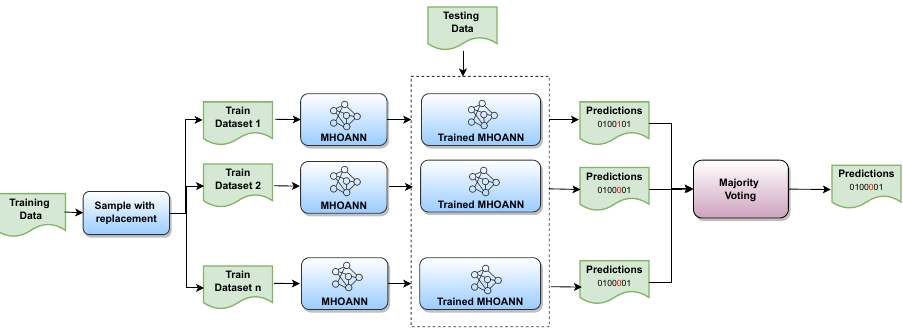
Figure 2. The MHOANN with a PSO or a CSO as the optimization technique and the cost sensitivity fitness function in the homogeneous majority voting ensemble learning paradigm architecture. Here, the training dataset was processed using sampling with replacements to generate n training datasets and then each dataset was used to train the MHOANN. Each trained MHOANN was then used to generate predictions using the same testing dataset and majority voting was used to generate the final